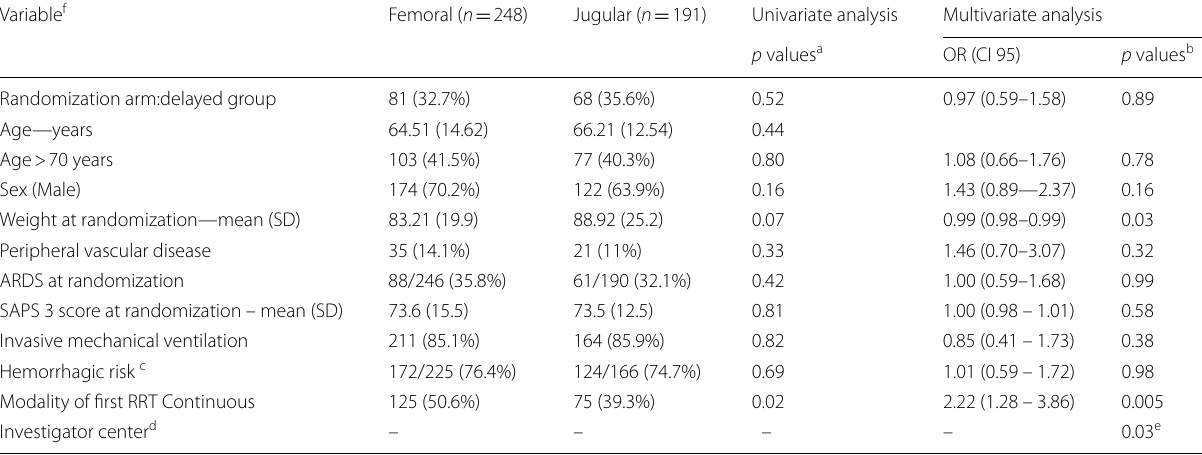
Table 3 Factors potentially associated with the choice of insertion site in univariate and multivariate analyses (between femoral and jugular for the first catheter, n 439) =